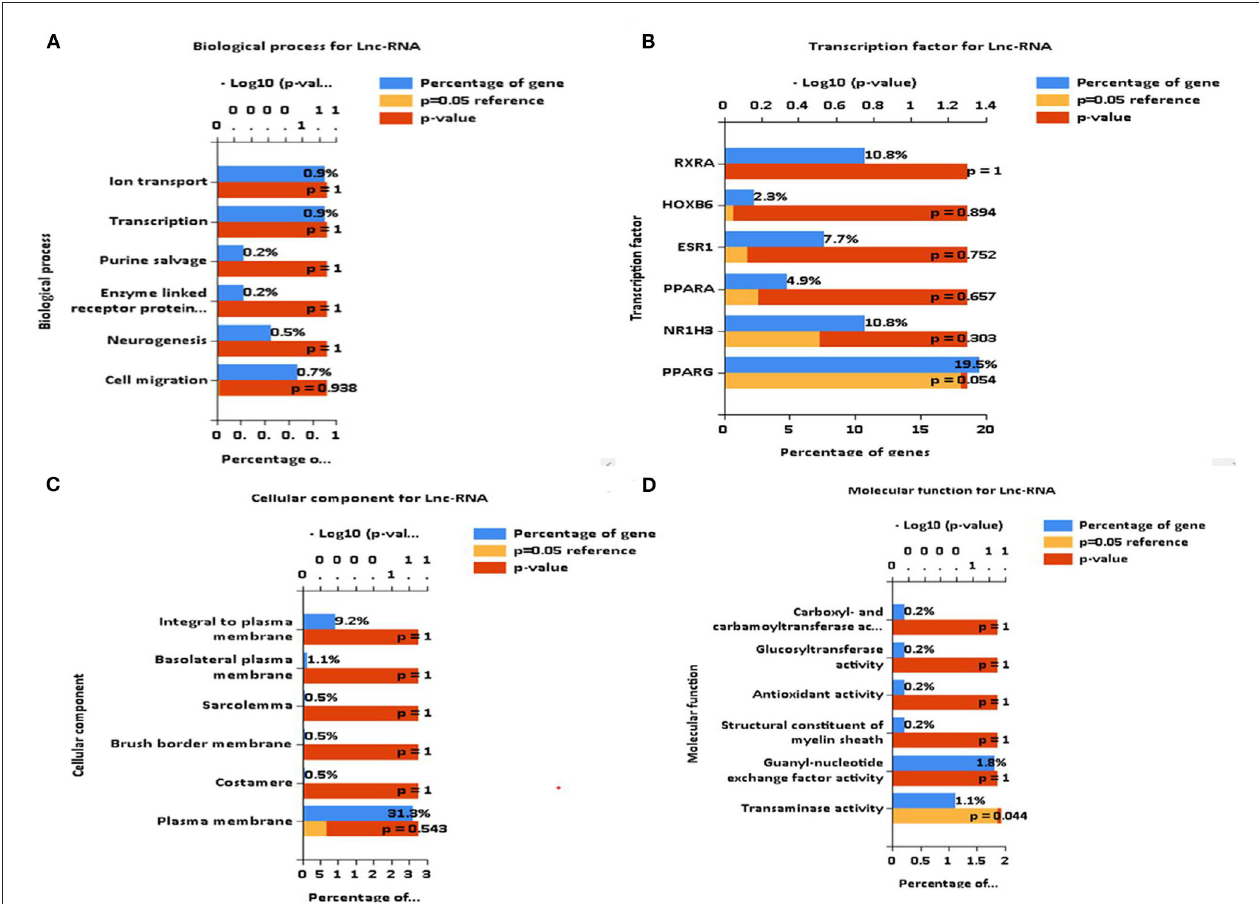
FIGURE 7 | Identification of biological functions of differentially expressed genes (DEGs). (A–D) FUNRICH identified several critical biological functions ranging from cellular components to transcription